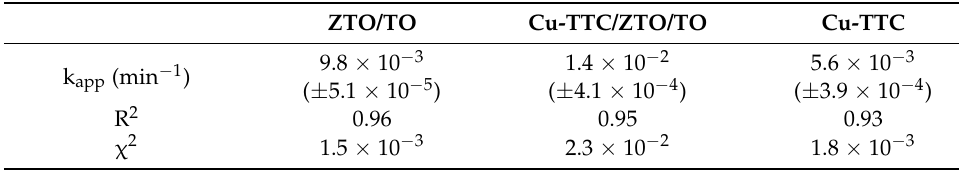
Table 1. Calculated k app values for the photodegradation of MB. ZTO/TO Cu-TTC/ZTO/TO